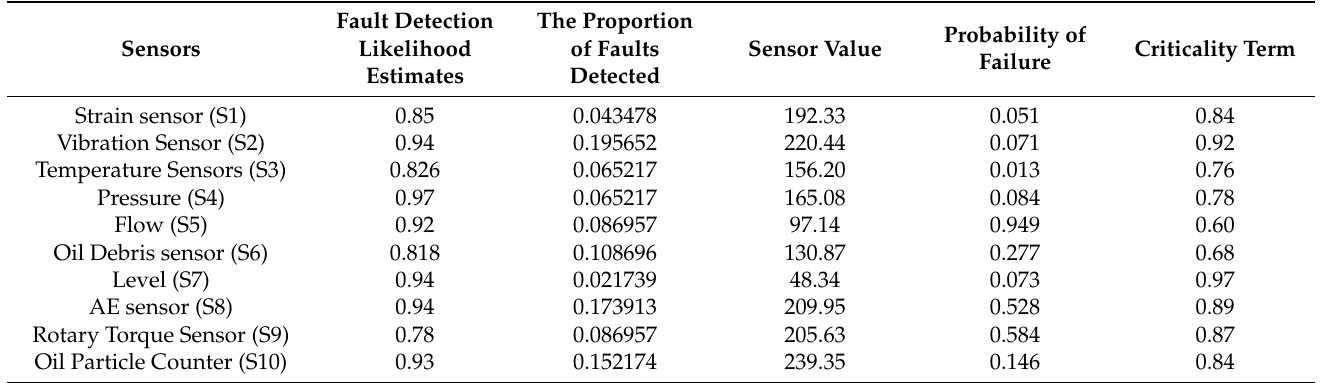
Table 5. The complete list of sensors and the associated criteria for sensor selection.